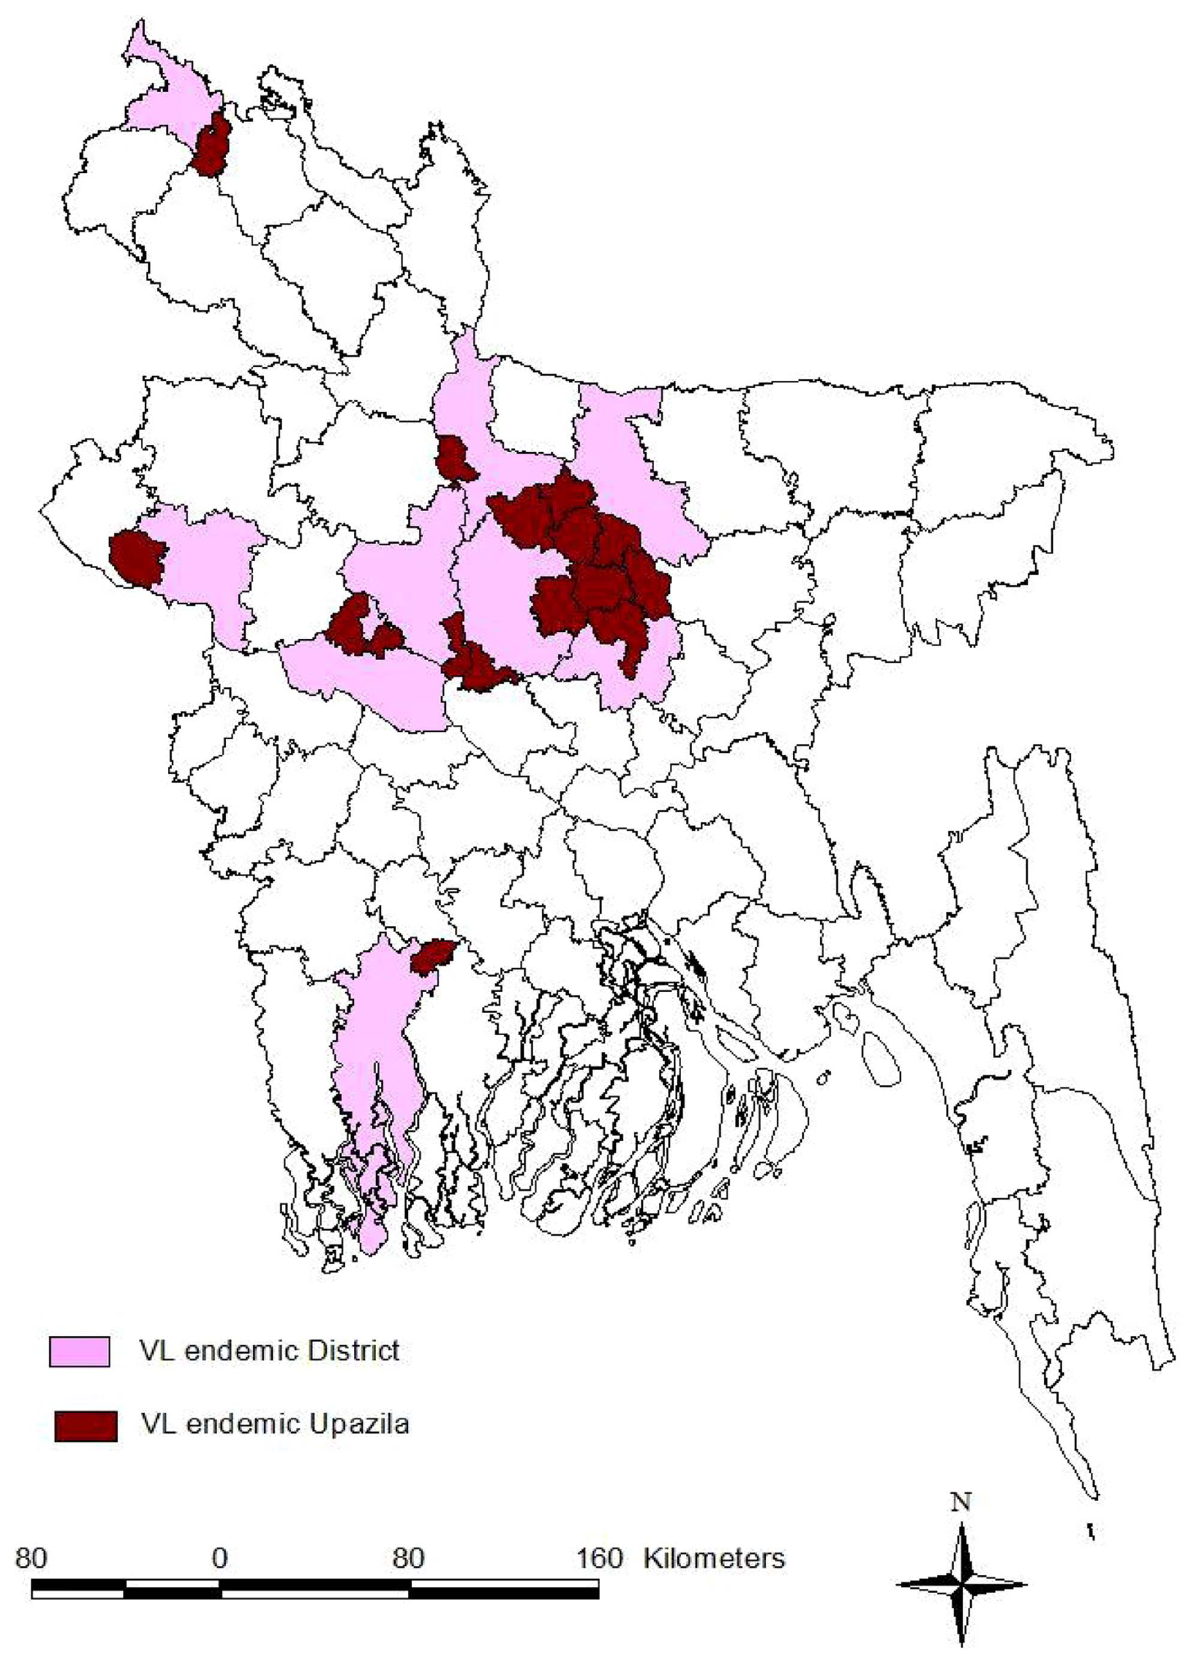
Figure 4. VL-endemic upazilas above target, where incidence rate is above one per 10,000 people from 2008 to 2013, with their respective districts. doi:10.1371/journal.pntd.0003020.g004 PLOS Neglected Tropical Diseases |